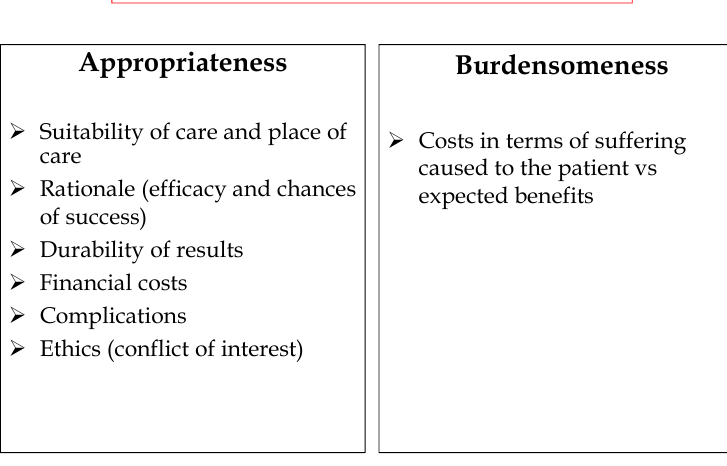
Figure 3. Factors affecting Proportionality of treatments.